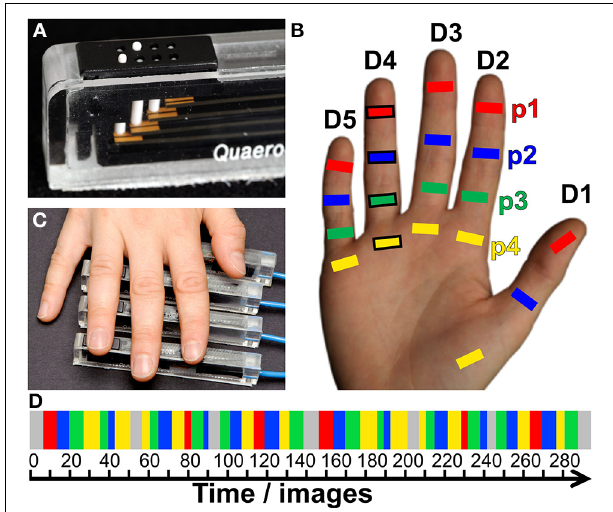
FIGURE 1 | Tactile stimulation. (A) Piezo-electric device used for vibrotactile stimulation of individual phalanges. (B) Stimulated digit areas for mapping (p1, red; p2, blue; p3, green; and p4, yellow). (C) One digit was stimulated per run, the example refers to the positioning of the piezo-electric devices (black frames in B ) to the ring finger. (D) Pseudo-randomized stimulation design (color code as above, baseline =